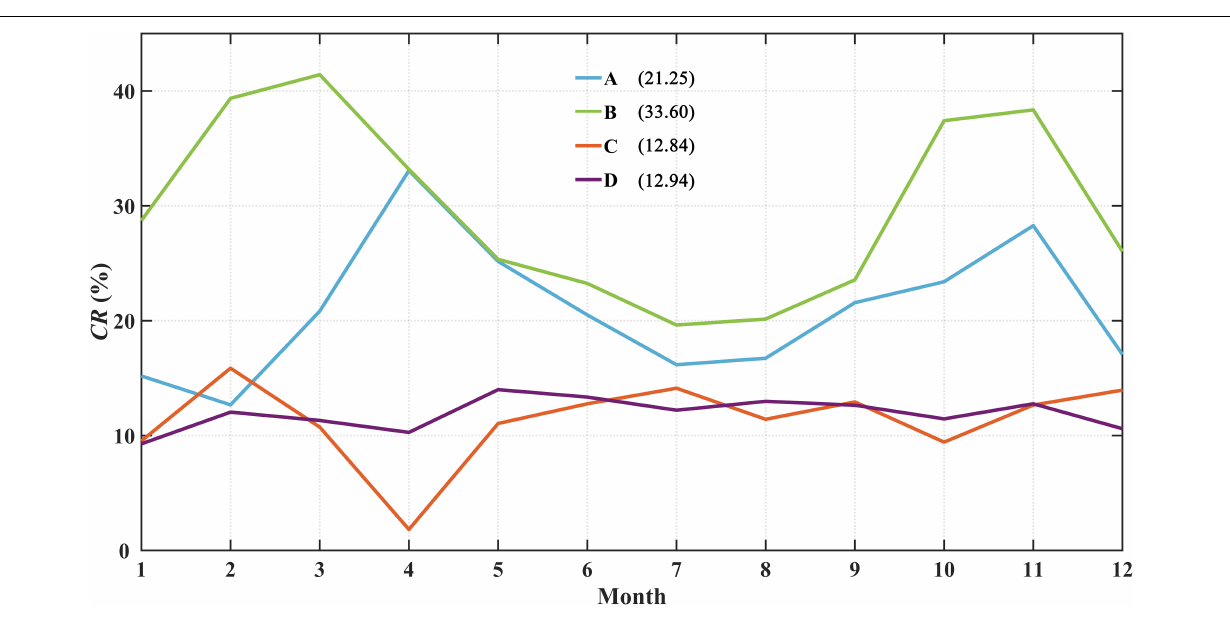
FIGURE 7 | Monthly CR s of spring-neap tidal cycles on Chl- a bloom in four areas. The annual mean CR s are shown in